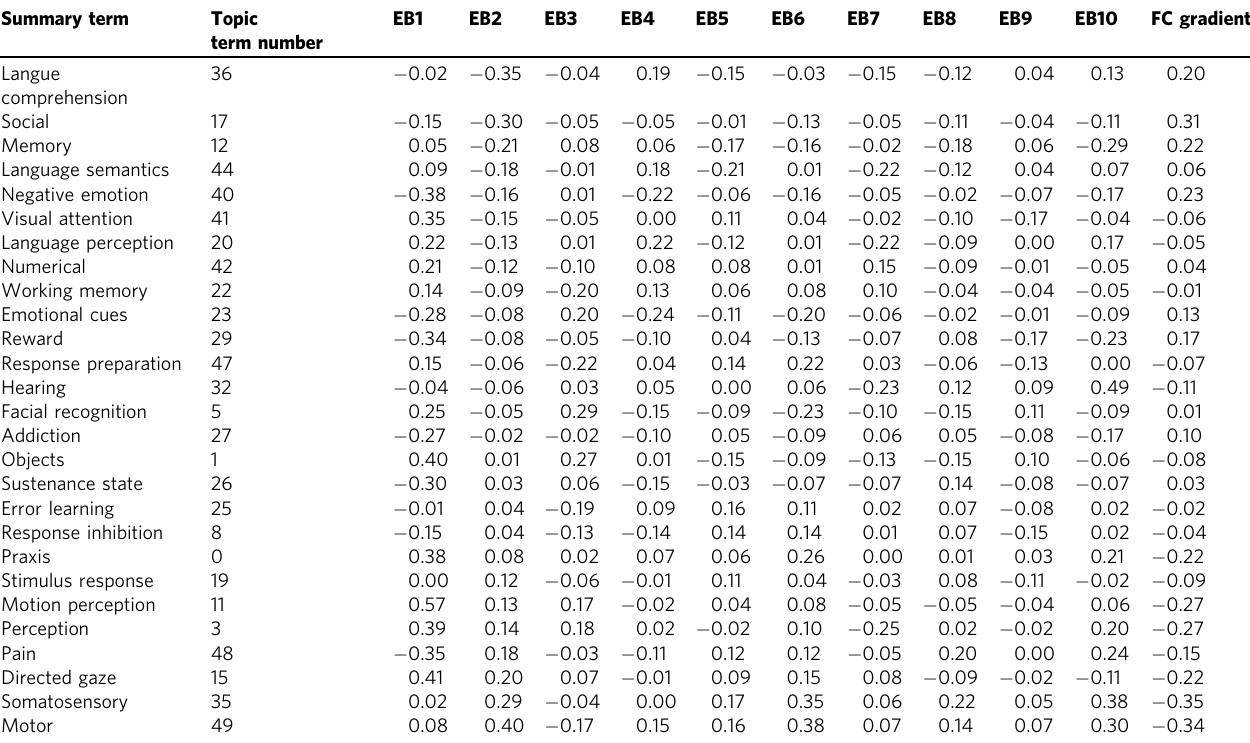
Table 3 Neurosynth topic term decoding of eigenbrains and principal gradient of functional connectivity. Summary